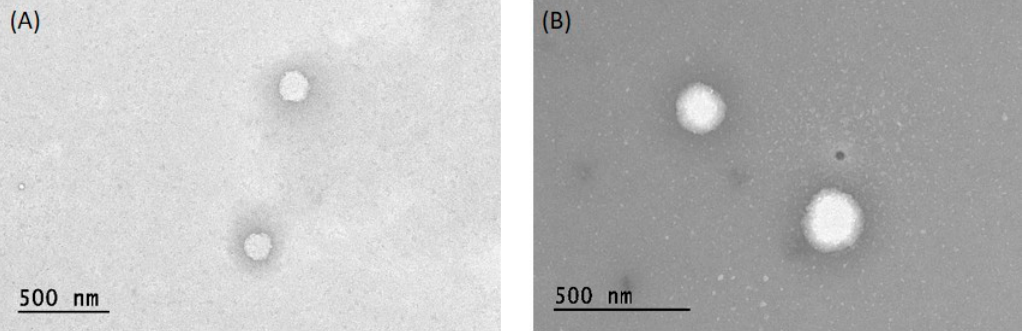
Figure 2. Transmission electron microscopy (TEM) of ( A ) and ( B ) samples. Figure 3 describes the hypothetical arrangement of unsaturated fatty acids and phos- pholipid, forming ufasomes structure.